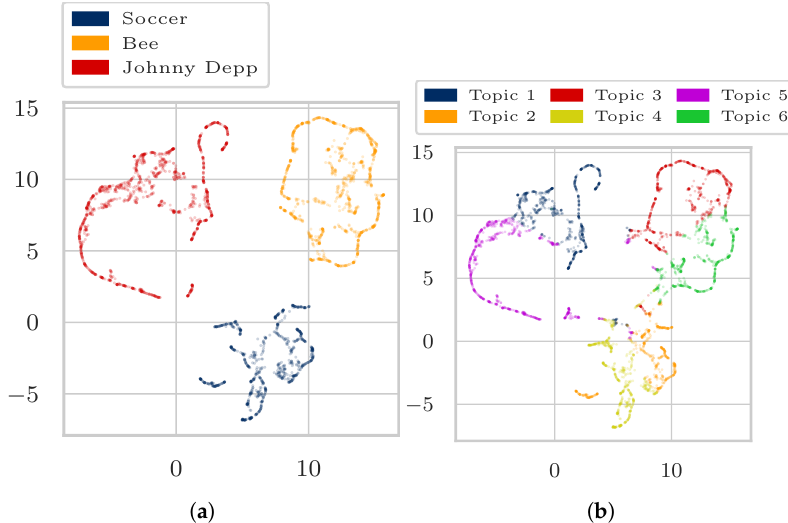
Figure A11. ( a ) 2-dimensional representation of word embeddings H colored by topic assignment. ( b ) 2-dimensional representation of word embeddings H colored by original Wikipedia article assignment (words that occur in more than one article are